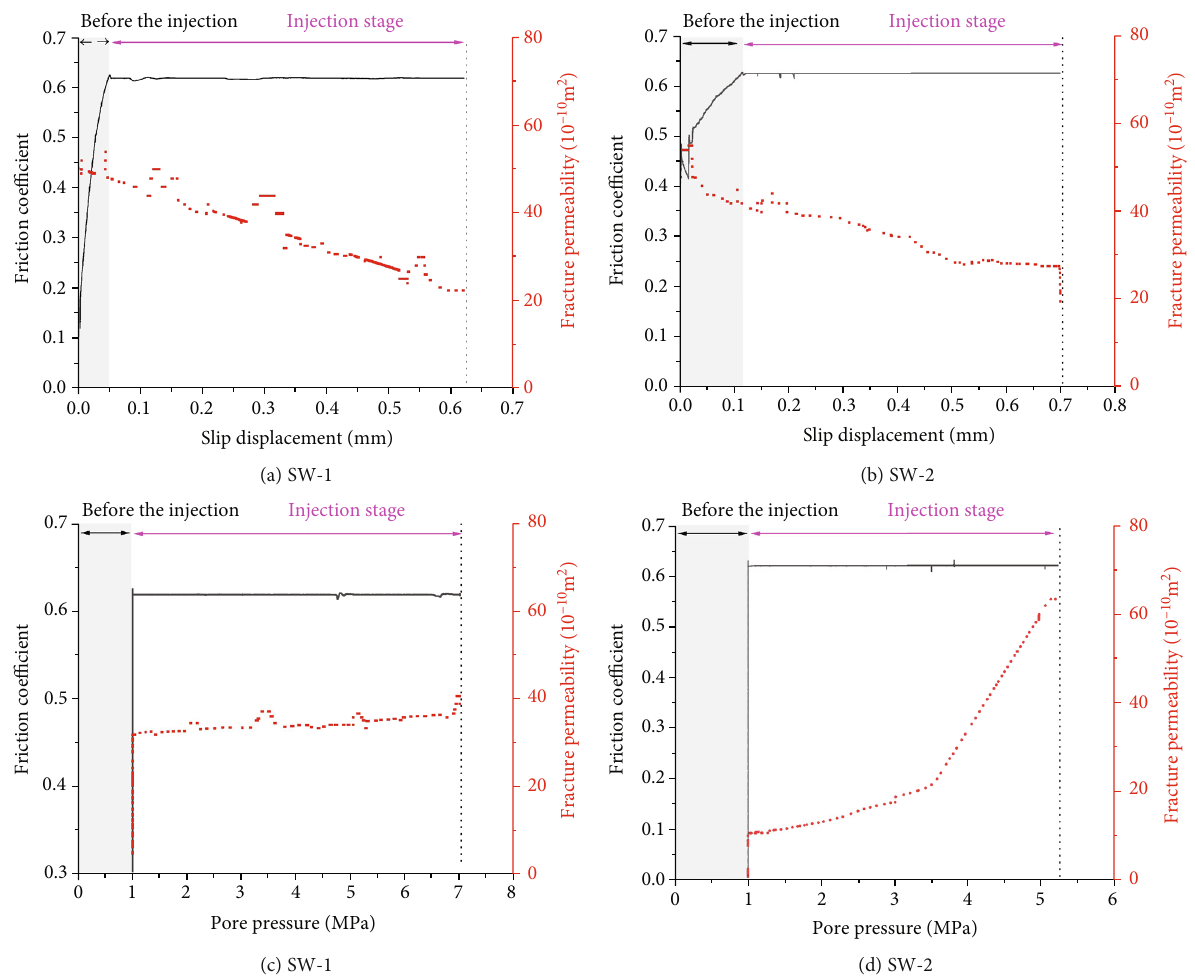
Figure 5: Friction coe ffi cient and permeability evolution. (a, b) The friction coe ffi cient and fracture surface permeability in SW-1 and SW-2 tests as functions of slip displacement, respectively. (c, d) The friction coe ffi cient and fracture surface permeability as a function of pore pressure in SW-1 and SW-2 tests,